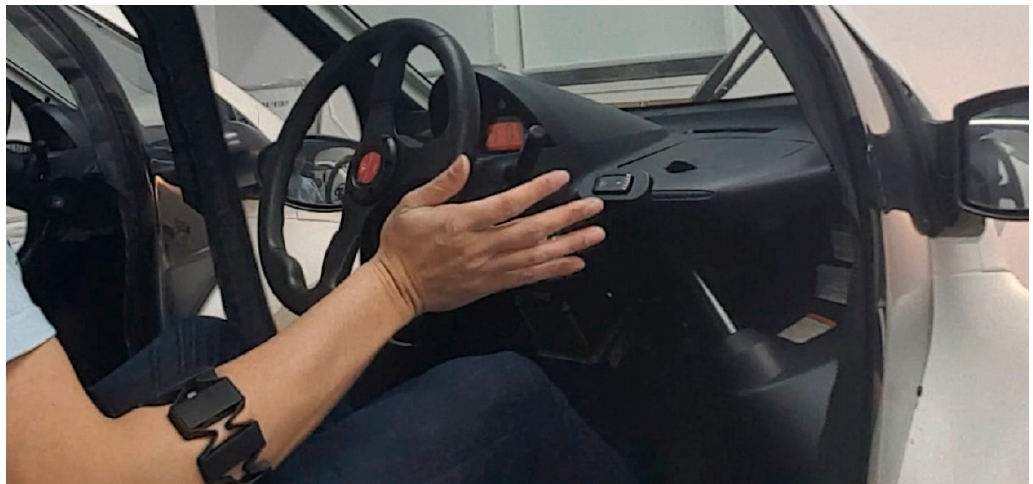
Figure 1. Myo armband used on right forearm to control steering wheel of COMS automobile.